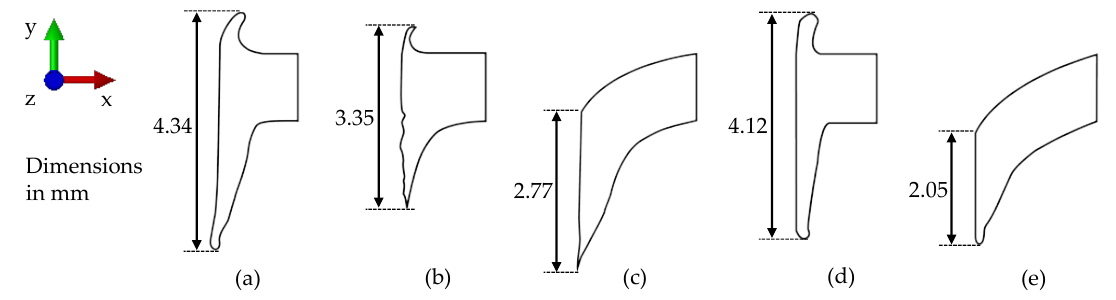
Figure 11. Geometry shapes of the resulting bushing for HX220 at a 1.2 mm sheet thickness: experiment ( a ); 3D FE ( b ); 2D FE ( c ); 3D FV ( d ); and 3D FV without rotation ( e ).